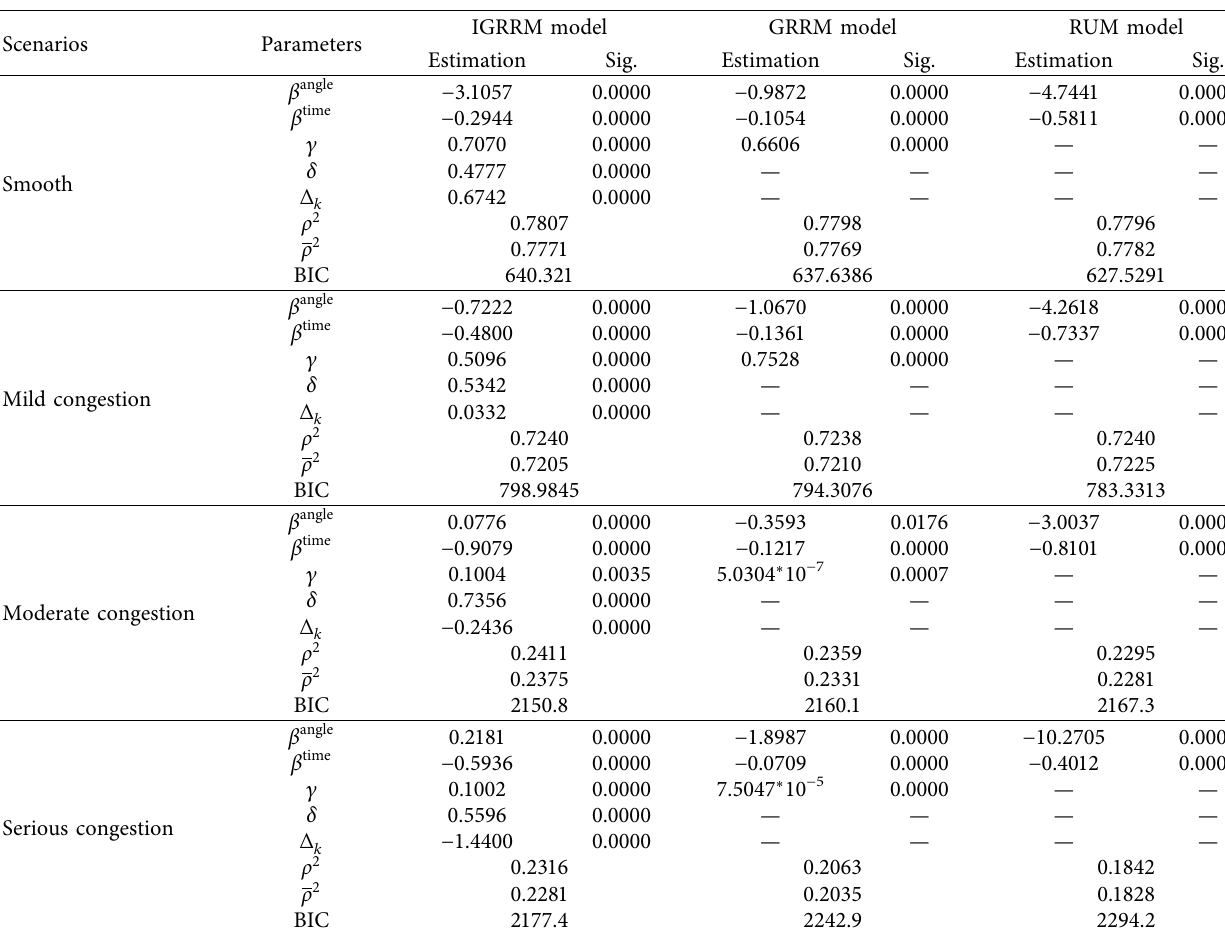
Table 3: Parameters estimation results of diferent